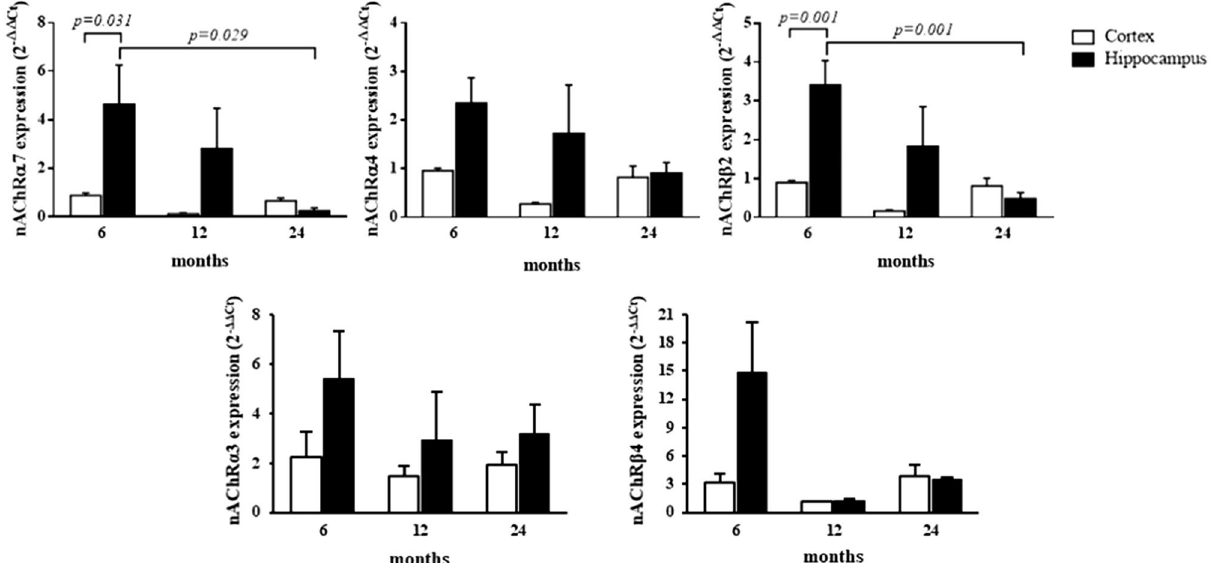
Figure 6. nAChRs expression levels in cortex and hippocampus at different postnatal ages. Bar plots graphically depict the mean and SEM of nAChR α7, α4, β2, α3, and β4 gene expression levels in cortex and hippocampus at different postnatal ages. Statistically significant p-values, after adjustment according to the FDR methods, are graphically depicted too.